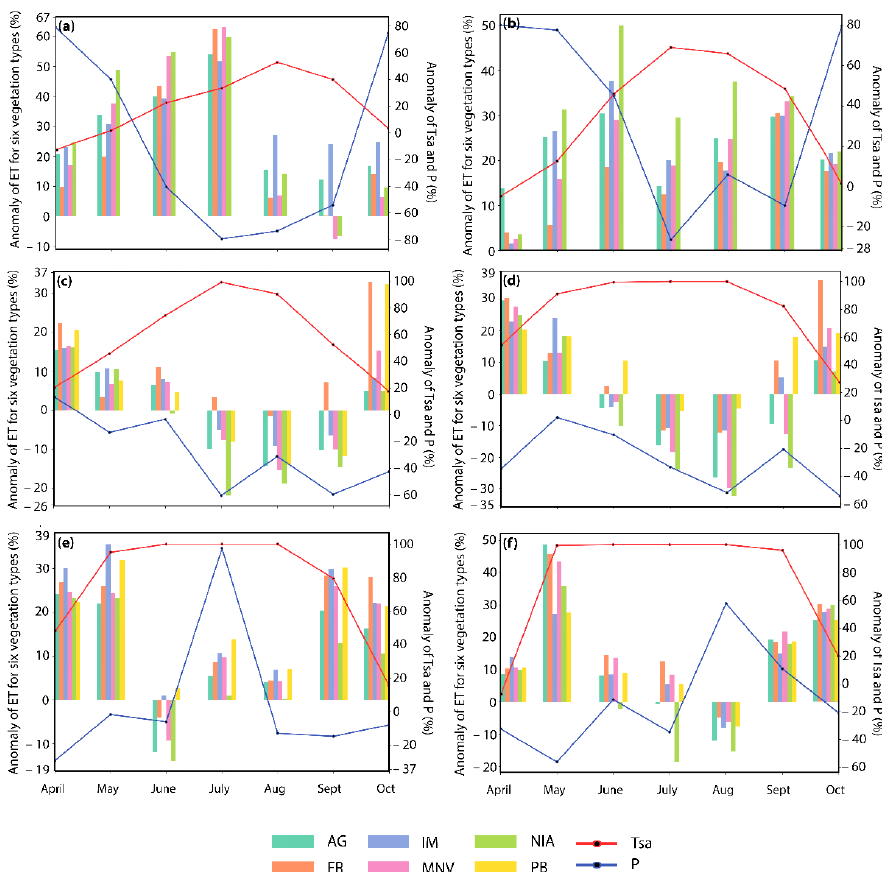
Figure 6. Changes in mean monthly ET anomalies (bar plots) for six different vegetation types [agriculture (AG), forest (FR), inland marshes (IM), mixed natural vegetation (MNV), and non- irrigated arable land (NIA), and peat bog vegetation (PB)], surface air temperature (T sa ) (red line), and precipitation (P) (blue line). Panels ( a–f ) represent regions 1–6. Both primary and secondary Y- axis are independently scaled for each region.